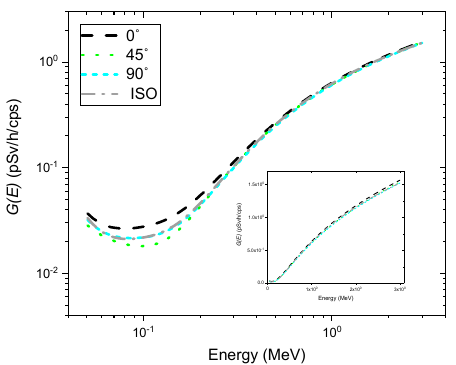
Figure 3. Spectrum-to-dose conversion operator (i.e., G ( E ) functions) for the angles of incidence of 0 ° (black dashed line), 45 ° (green dotted line), and 90 ° (cyan short-dashed line), and isotropic geometry (gray dash-dotted line). The inset shows the same graph on a linear scale.